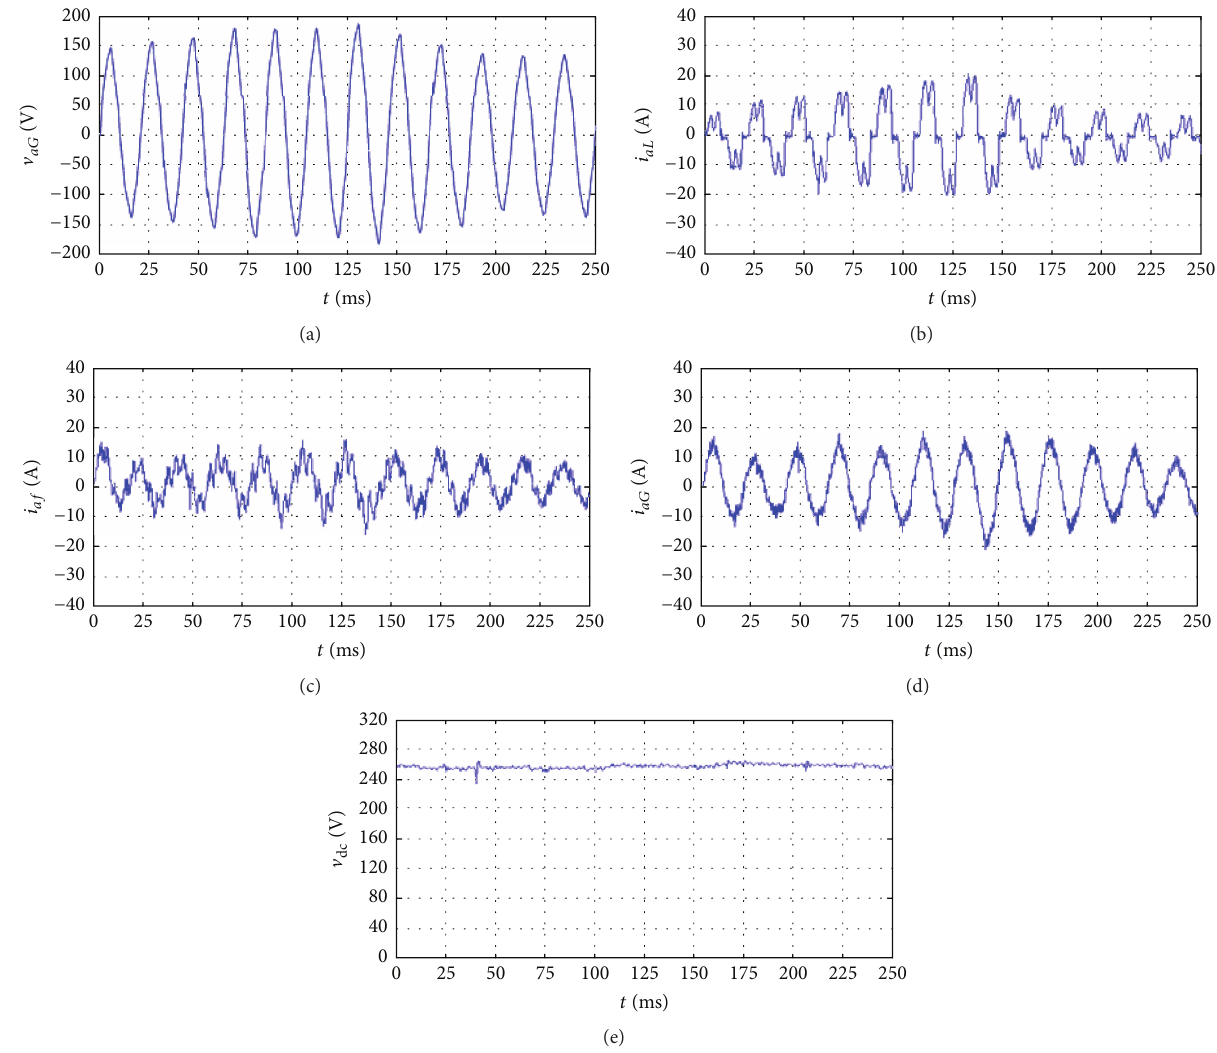
Figure7:Experimentalresultsoftheproposedsystemwithbalancednonlinearload:(a)phasevoltage V 𝑎𝐺 ofthewindgenerator;(b)nonlinear load current 𝑖 𝑎𝐿 ; (c) active power filter current 𝑖 𝑎𝑓 ; (d) line current 𝑖 𝑎𝐺 of the wind generator; (e) DC-link voltage V